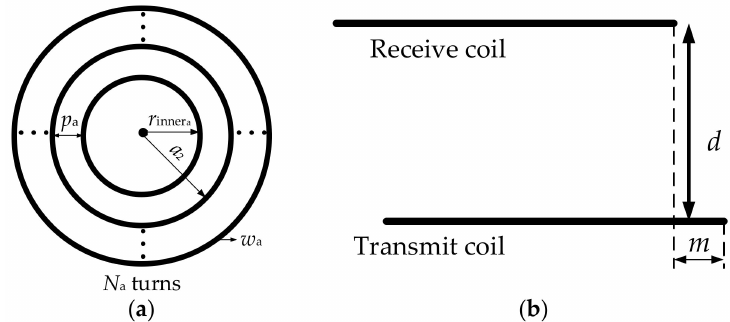
Figure 4. ( a ) Vertical view of a circular flat spiral coil; ( b ) elevation view of two horizontally